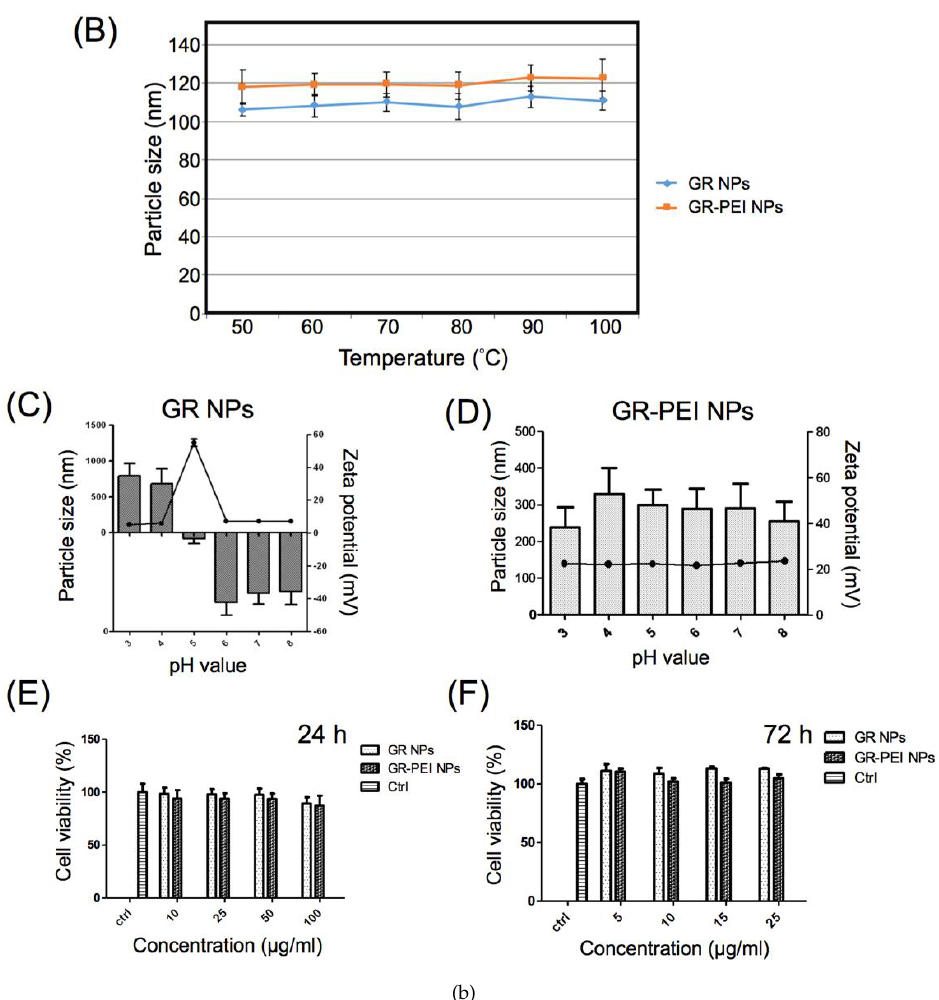
Figure 2. The stability of GR NPs and GR-PEI NPs. GR NPs and GR-PEI NPs were incubated in PBS and PBS with 10% fetal bovine serum (FBS) at 37 °C for up to 28 days ( A ) and heated up to 100 °C ( B ). The particle size (bar) and zeta potential (line) of GR NPs ( C ) and GR-PEI NPs ( D ) were detected in the different pH value conditions. ( E ) The cytotoxicity assay of GR NPs and GR-PEI NPs. Cytotoxicity of excess GR NPs and GR-PEI NPs (up to 100 μg/mL) was evaluated. Each formulation was incubated with 3T3 fibroblast cells for 24 h followed by MTS assay analysis. ( F ) The relative cell viability of 3T3 fibroblast cells incubated with GR NPs and GR-PEI NPs for 72 h. The representative results are shown as M ± SD ( n = 3). Each bar represents the means of three determinations ±SD.